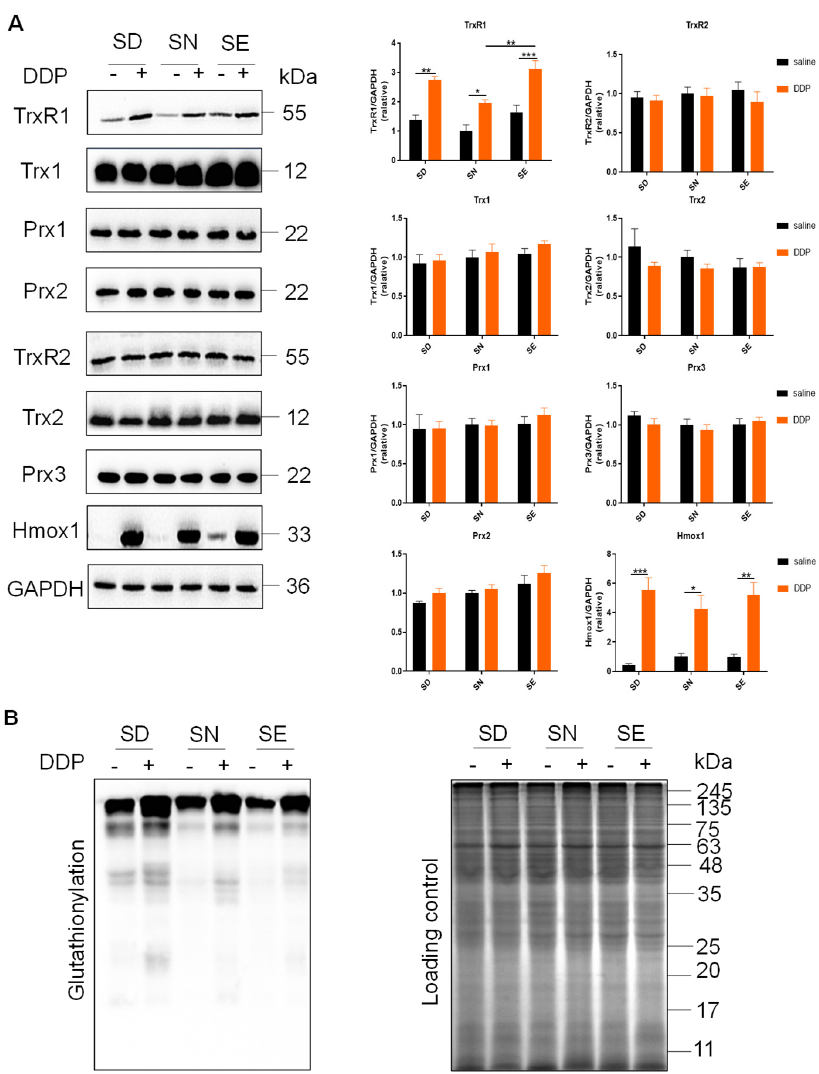
Figure 6. Effects of selenium status on redox-related protein expression and glutathionylation level upon DDP treatment. ( A ) Cytosolic and mitochondrial protein expression upon DDP treatment. Data were normalized by comparing the protein levels of targeted group with those in selenium- normal mice treated with saline (=1). ( B ) Protein glutathionylation within mice kidney after DDP treatment. The CBB-stained gel was used as a loading control, n = 4. CBB, Coomassie brilliant blue. Data are shown as mean ± SEM; * p < 0.05; ** p < 0.01; *** p < 0.001; two-way ANOVA, n = 4. SD, selenium-deficient; SN, selenium-normal; SE, selenium-enriched; DDP,